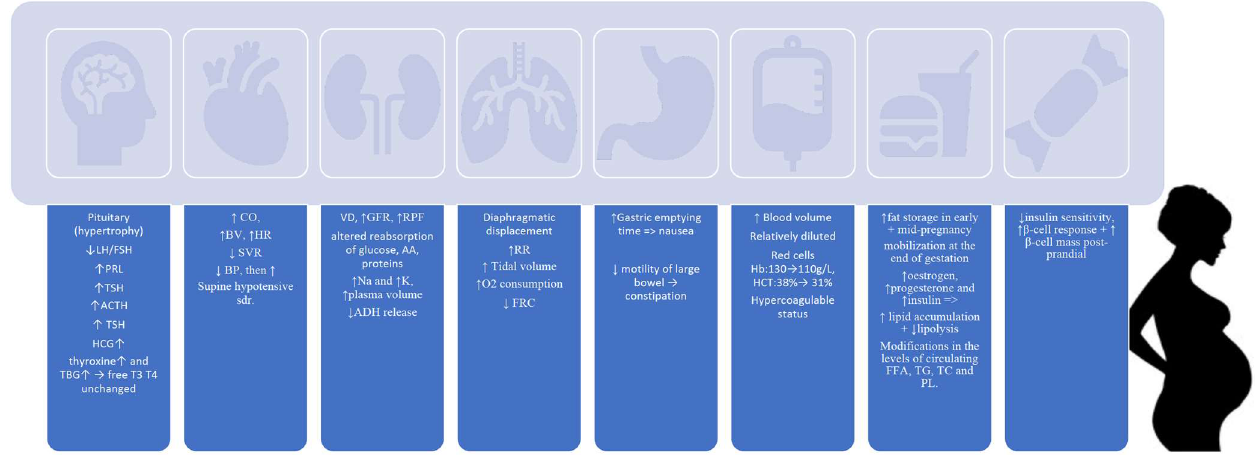
Figure 1. Physiological modifications occur during pregnancy in the endocrinological, cardiovascular, renal, respiratory and gastro-intestinal systems, with adaptations of the haematological area and lipid and glucose metabolism. LH= luteinising hormone, FSH = follicle-stimulating hormone, PRL = prolactin, ACTH = adrenocorticotropic hormone, TSH = thyroid-stimulating hormone, TBG = thyroid-binding globulin, CO = cardiac output, BV = blood volume, HR = heart rate, SVR= Systemic Vascular Resistance, BP = blood pressure, VD = vasodilatation, GFR = glomerular filtration rate, RPF = renal plasmatic flow, AA = amino acids, Na = sodium, K = potassium, RR = respiratory rate, FRC= functional residual capacity, Hb = haemoglobin, HCT = haematocrits, FFA = free fatty acids, TG = triglycerides, TC = total cholesterol, PL = phospholipids.